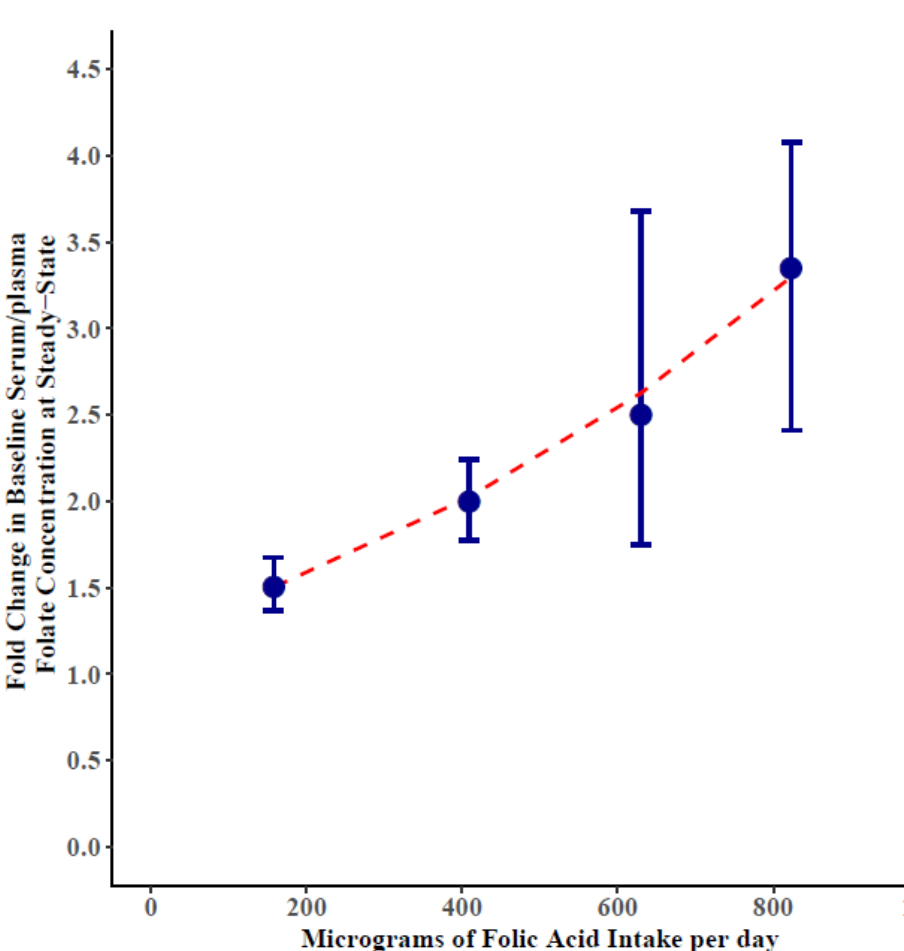
Figure 2. Folic acid intake and change in ratio of steady-state to baseline serum/plasma folate concentrations by folic acid dosage. The blue dot is the point estimate of the folate change in serum/plasma folate concentration plotted at steady-state of the median folic acid intake for the range (50–250, 300–500, 563–714, and 800–1429 µ g/day) and 95% Credible Intervals (CI) error bars. The slope of the regression model to estimate concentration changes across the entire range of dosages is shown. The ratio of steady-state to baseline serum/plasma folate concentration increased by 11.6% (95% CI: 8.4, 14.9) for every increase in 100 µ g/day of folic acid dose.